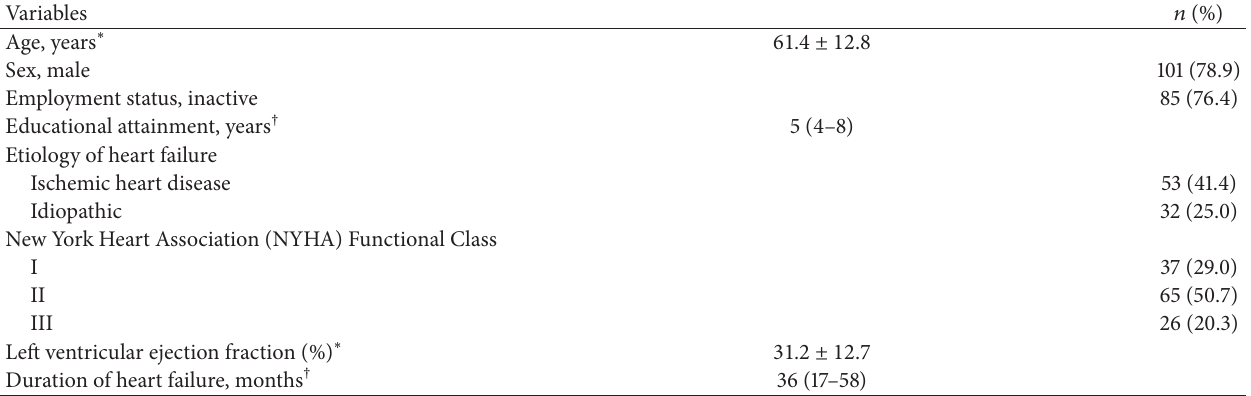
Table 1: Sociodemographic and clinical characteristics of the sample (𝑛 = 128)